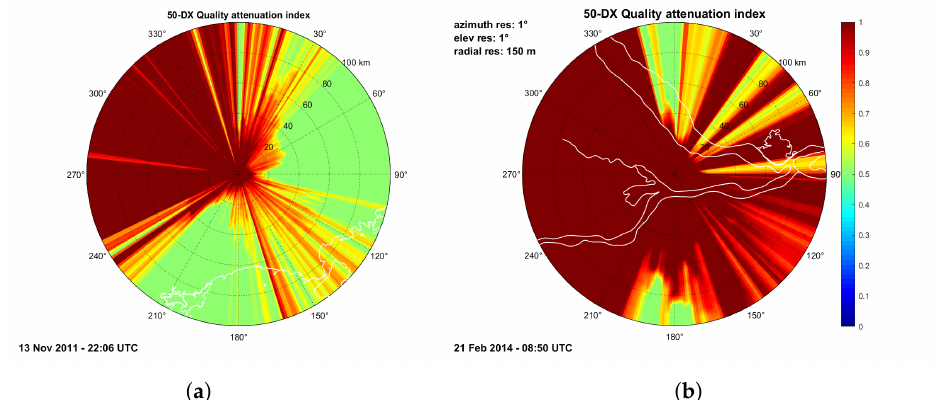
Figure 7. ( a ) Attenuation correction map at lowest elevation angle associated with radar in ( a ) Vale do Paraíba on 13 November 2011 at 22:06 UTC (center) and ( b ) Manaus on 21 February 2014 at 8:50 UTC